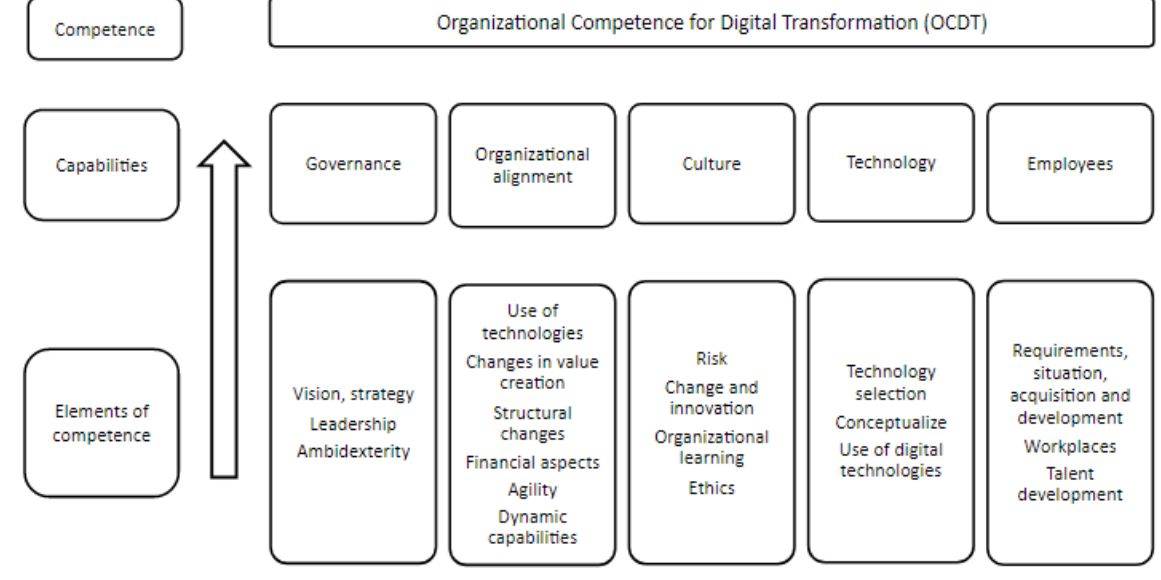
Figure 1. Organizational Competence for Digital Transformation. Source: González-Varona, Acebes et al.